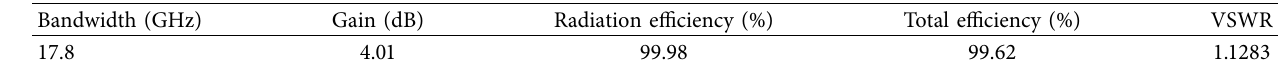
Figure 7: Surface current in free space at 60GHz. Table 2: Other antenna parameters